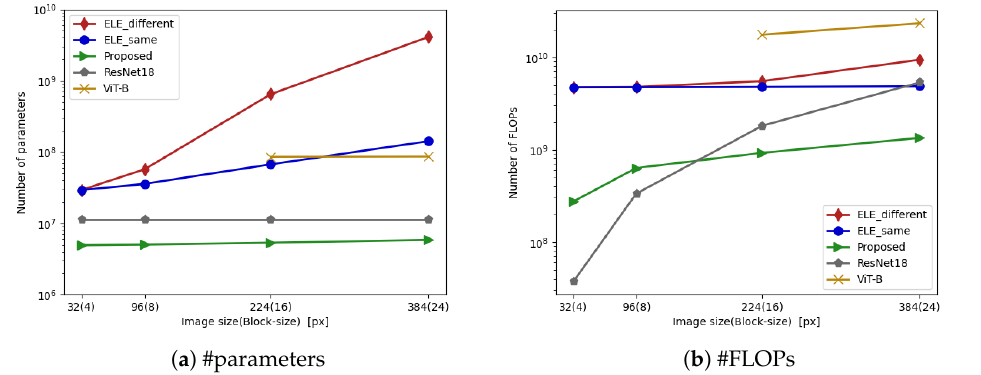
Figure 5. Number of parameters and FLOPs in privacy-preserving DNNs. Both “ELE_same” and “ELE_different” consist of ELE-AdaptNet and Shakedrop